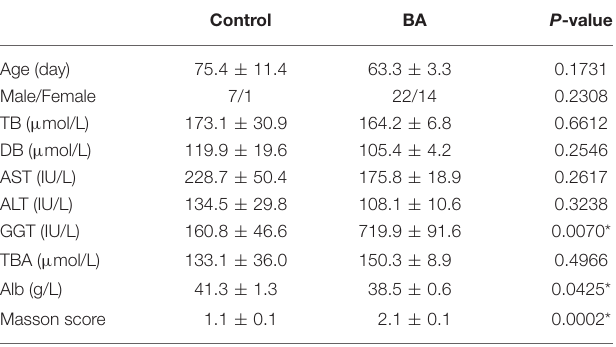
TABLE 2 | Patients’ information of control and BA groups. TABLE 3 | Patients’ information of g-BA and p-BA